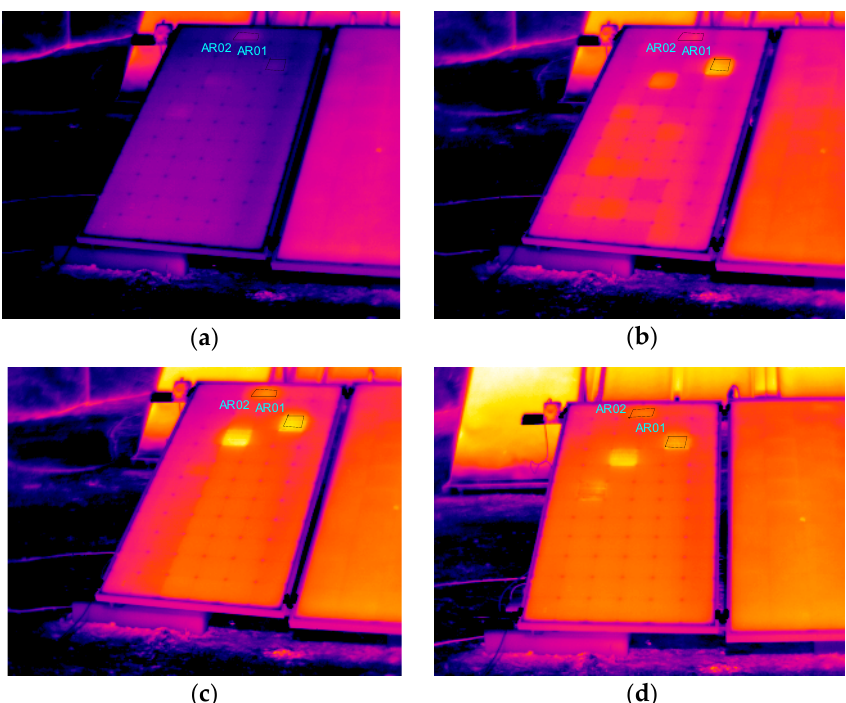
Figure 14. Monocrystalline PV module IR images; ( a ) normal operation mode, ( b ) cell E3 covered, ( c ) cells E3 and C4 covered, and ( d ) cells E3, C4, and B6 covered.